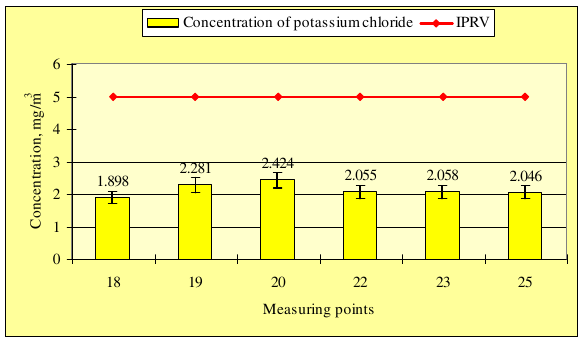
Fig 13 . Distribution of dust concentrations at Terminal of Powdery Manure Discharge in zone